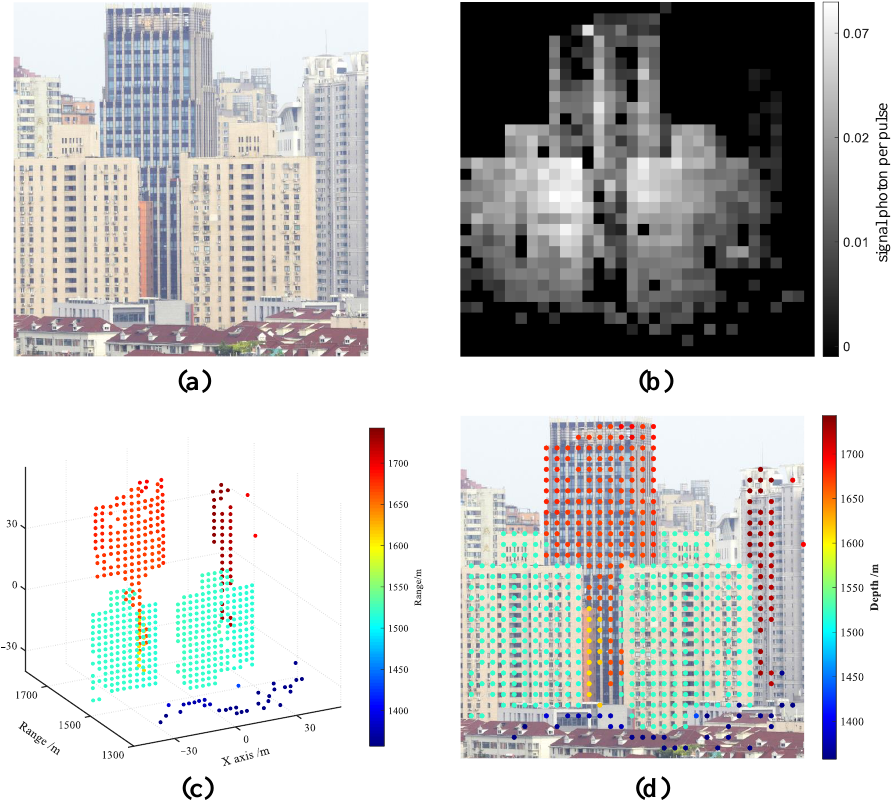
Figure 9. 3D imaging results for targets distributed between 1300 and 1700 m. ( a ) visible image; ( b ) distribution of signal photon number per pulse; ( c ) retrieved 3D point cloud in LiDAR’s FoV; ( d ) fusion results with visible